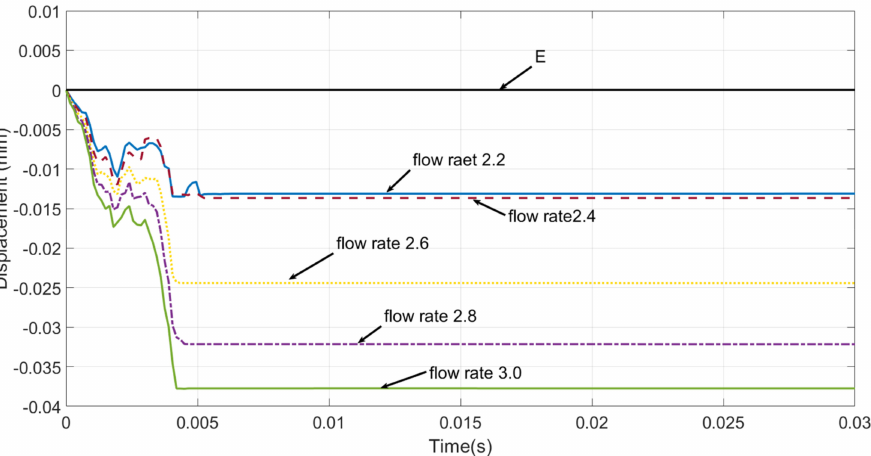
Figure 8. Relative displacement changing graph of sensor characteristic point under impacts of different momentum jets in the X direction.